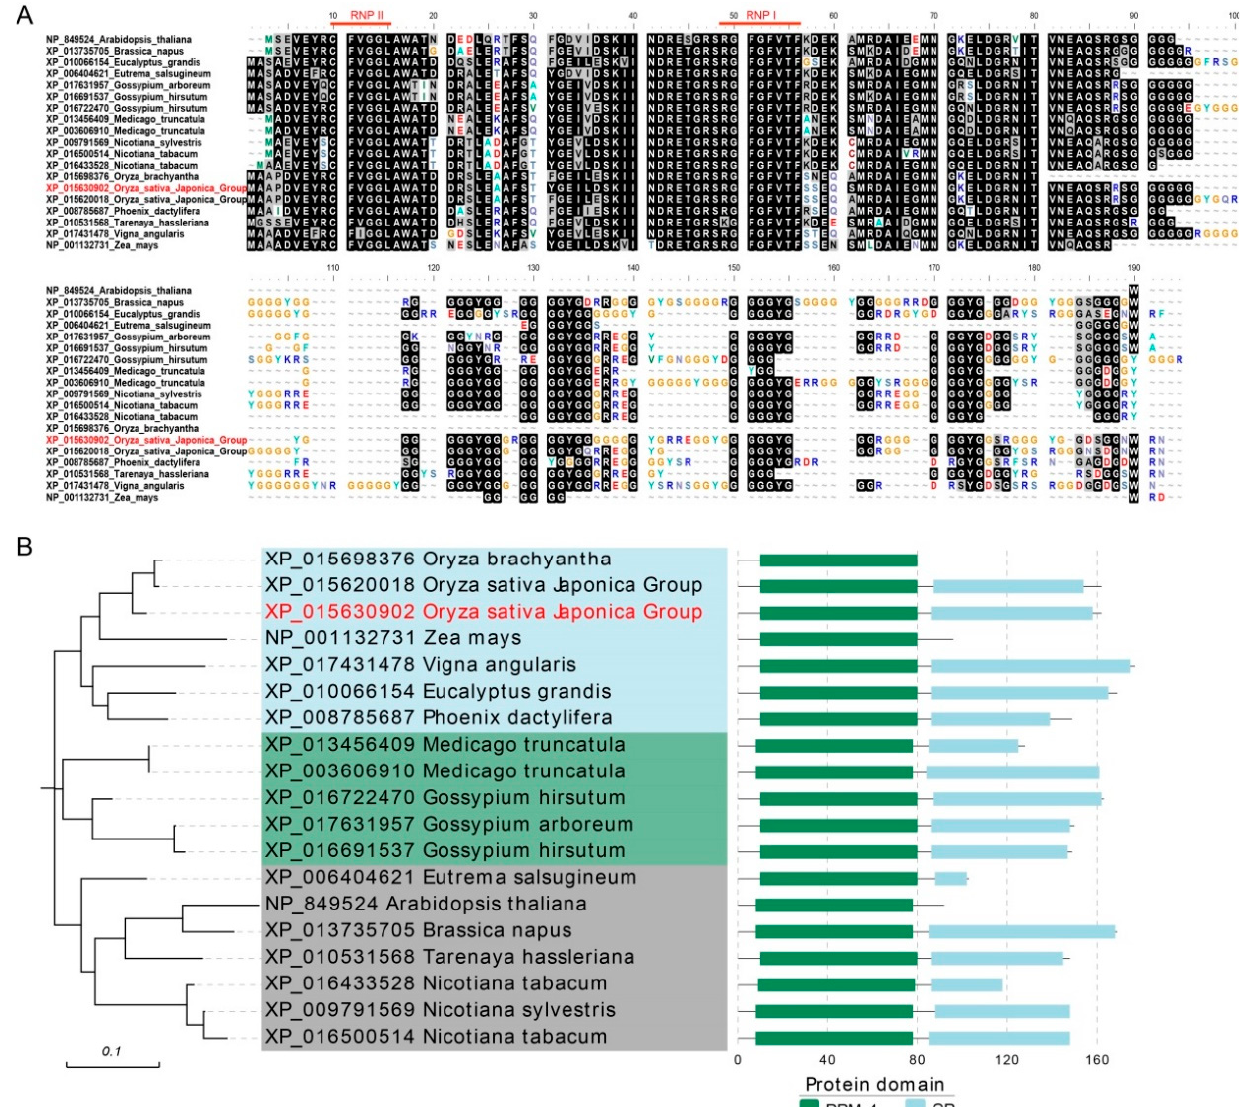
Figure 1. Evolutionary analysis of OsGRP3 in different species. ( A ) multiple sequence alignment of 19 homologous GRPs proteins of different species were aligned by ClustalW and decorated using Bioedit v.7.1.3.0. The red one (XP_015630902) indicates OsGRP3. XP_015620018 indicates OsGR-RBP4. The black background indicates conserved amino acids. RNPI (RGFGFVTF; (K/R)G(F/Y)(G/A)FVX(F/Y)) and RNPII (CFVGGL; (C/I)(F/Y)(V/I)(G/K)(G/N)L) are two RNA-binding consensus sequences. ( B ) Phylogenetic tree of the 19 proteins. Different background colors represent different clades. The corresponding protein structures are shown on the right, and the numbers of amino acids are indicated on the lower coordinate.